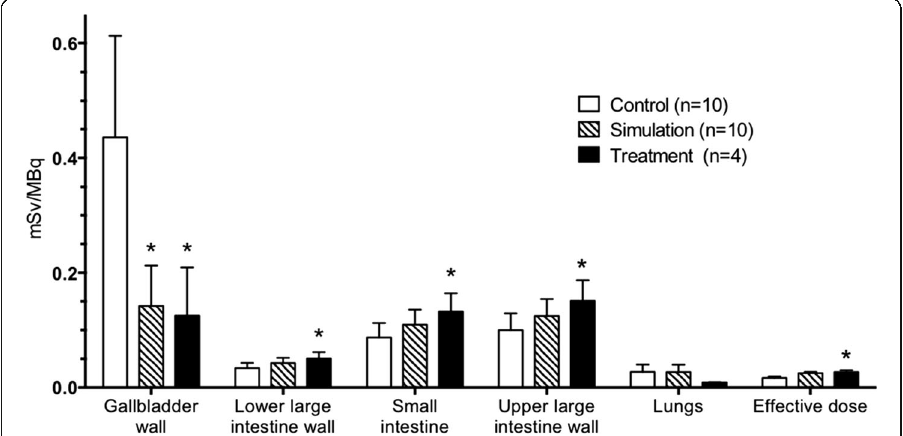
Fig. 5 Comparisons of regional doses between control, simulation, and intervention groups. Legend: Asterisks indicate groups whose mean regional absorbed radiation doses are significantly different from the control group for that region using Tukey HSD analysis ( P ≤ 0.027). Note that simulation and intervention groups were not significantly different for any of the regions shown ( P ≥